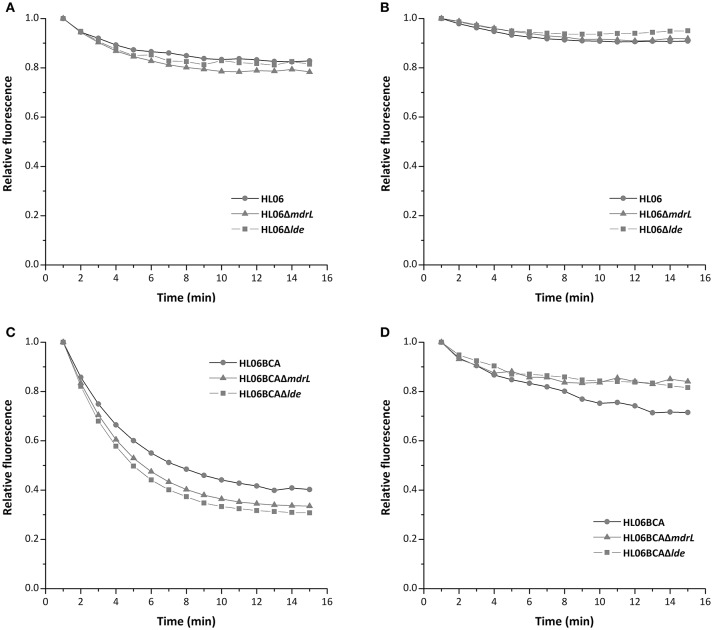
Evaluation of EtBr efflux activity for HL06, HL06ΔmdrL, and HL06Δlde under different conditions: (A) In the presence of glucose without reserpine; (B) in the presence of glucose and reserpine. Evaluation of EtBr efflux activity for HL06BCA, HL06BCAΔmdrL, and HL06BCAΔlde under different conditions: (C) in the presence of glucose without reserpine; (D) in the presence of glucose and reserpine.